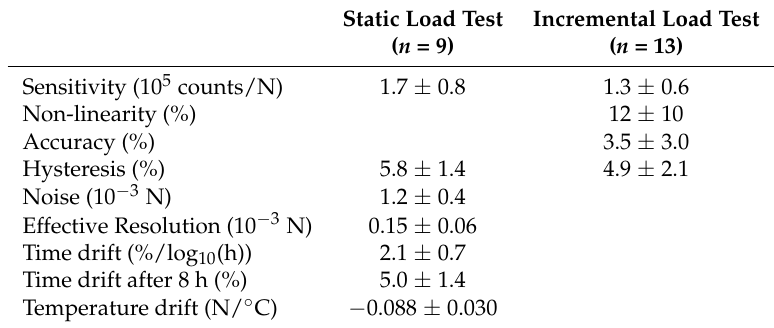
Table 2. Sensor performance . All characteristics are presented as mean ± standard